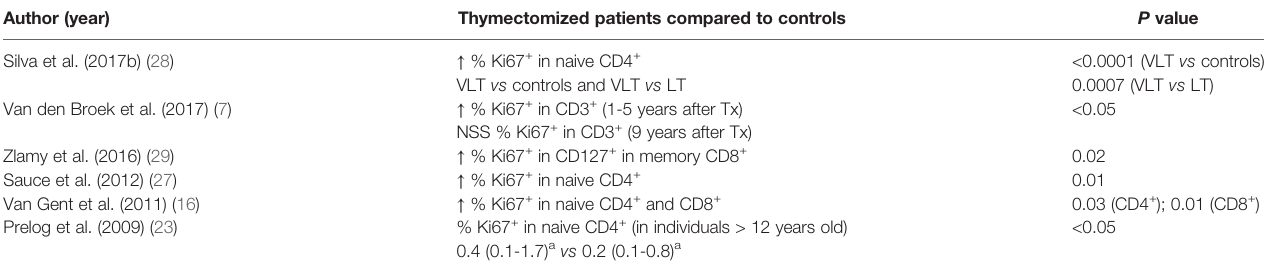
TABLE 6 | Main results regarding expression of Ki67 of included studies.